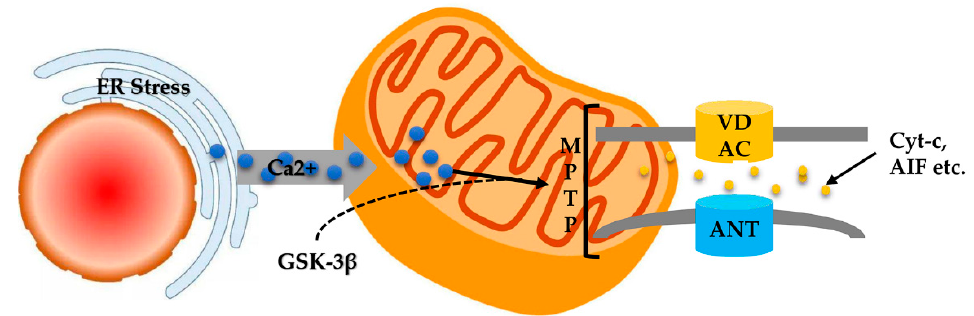
Figure 5. ER stress-induced MPTP opening. ER and mitochondria are firmly connected, ER stress is an adaptive response to the accumulation of misfolded proteins in the ER. With the continuation of ER stress, Ca 2+ is released from the ER reservoir to the mitochondria, resulting in mitochondrial Ca 2+ overload, further resulting in MPTP activation and cytochrome C release.